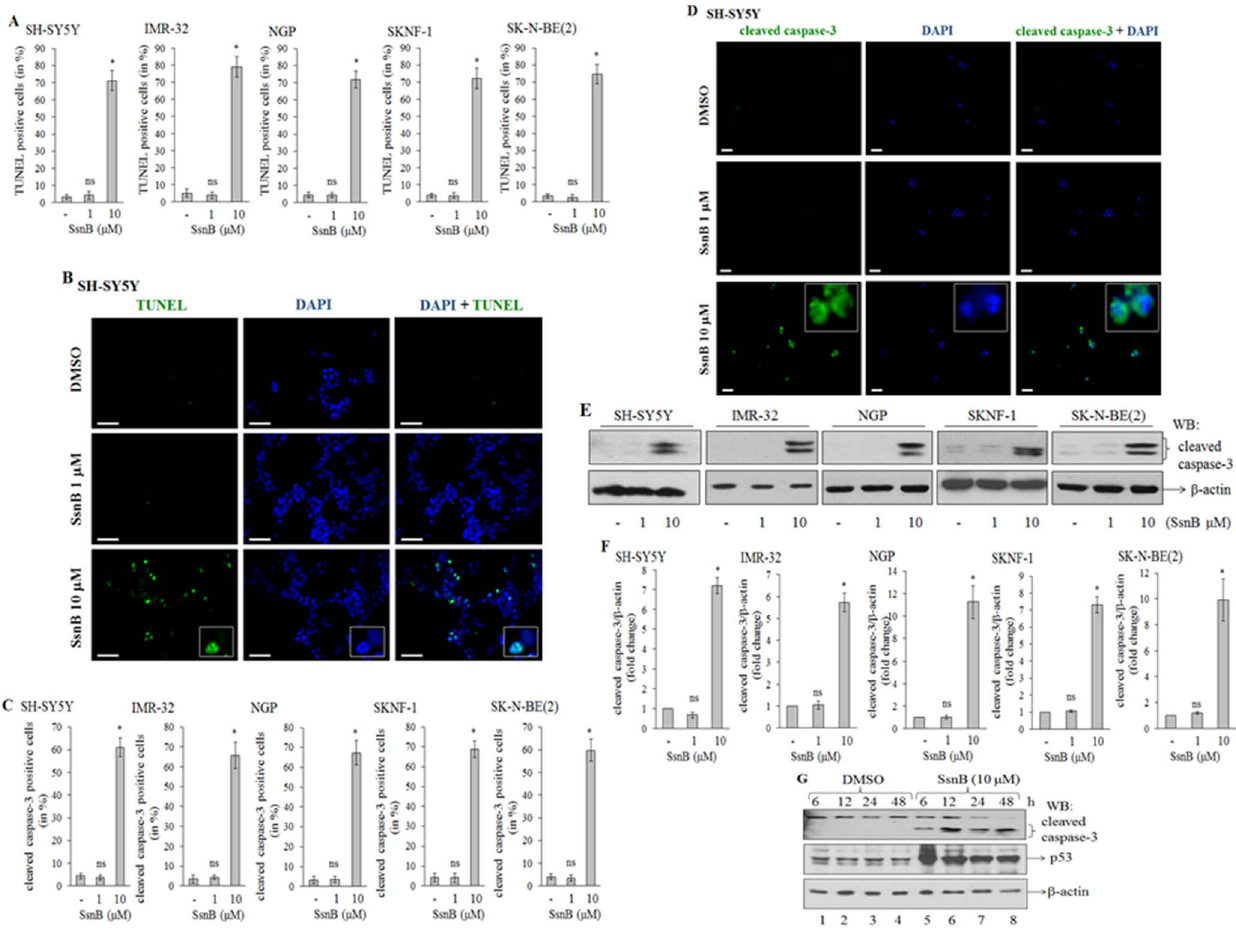
Figure 3. SsnB induces apoptotic cell death. SsnB-treated neuroblastoma cells (SH-SY5Y and IMR-32 for 2 days, NGP for 3 days, and SKNF-1 and SK-N-BE(2) cells for 4 days) were used to monitor DNA fragmentation by TUNEL assay (A and B), and cleaved caspsase- 3 by immunofluorescence (C and D), and Western blotting (E and F). DAPI (blue) was used to stain nuclei. Signals were examined under fluorescence microscope; number of TUNEL-positive cells (green) or cleaved caspase-3 positive cells (green) were counted by ImageJ programme and plotted ( A and C ). Bar represents mean and S.D. of three independent experiments and * p , 0.05 vs control. ns = nonsignificant vs control. ( B ) Representative images from SH-SY5Y TUNEL-assay showing that the number of TUNEL-positive cells (green, as indicator of DNA fragmentation) were more in SsnB-treated groups (10 m M) compared to DMSO or SsnB (1 m M). The enlarged overlapped and individual images showing cells with a typical apoptotic nucleus as stained with DAPI (blue) and TUNEL (green), and TUNEL staining is observed in those cells which had fragmented nuclei. Scale bar=100 m m. ( D ) Representative immunofluorescence images showing staining for cleaved caspase-3 (green) in SH-SY5Y cells. Enlarged single and overlapped images showing that cleaved caspase-3 staining is exclusively present in the cytoplasm. Scale bar=100 m m. ( E ) Western blot for cleaved caspase-3. Total cell extracts prepared from neuroblastoma cells treated with or without SsnB (1 m M or 10 m M) were separated on 14% SDS- polyacylamide gel and Western blotted with cleaved caspase-3 antibody. b -actin was used to check loading differences. Protein signal intensities were calculated form ImageJ programme and the ratio of cleaved caspase-3/ b -actin were plotted ( F ). Bar represents mean and S.D. of three independent experiments and * p , 0.05, SsnB 10 m M vs control; ns = nonsignificant vs control. ( G ) Western blots showing protein expression level